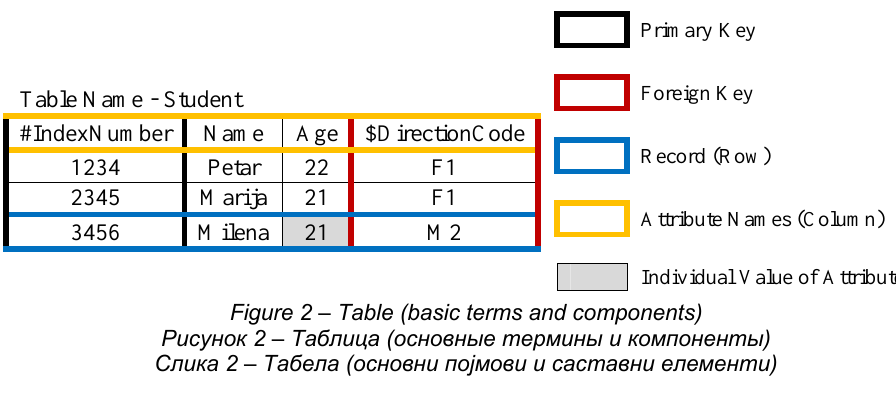
Figure 2 – Table (basic terms and components) Рисунок 2 – Таблица ( основные термины и компоненты ) Слика 2 – Табела ( основни појмови и саставни елементи